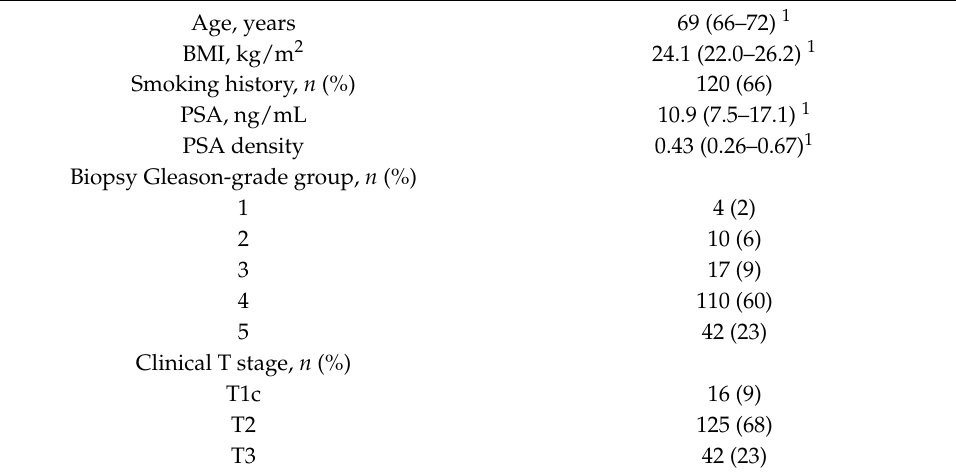
Table 1. Summary of preoperative patient